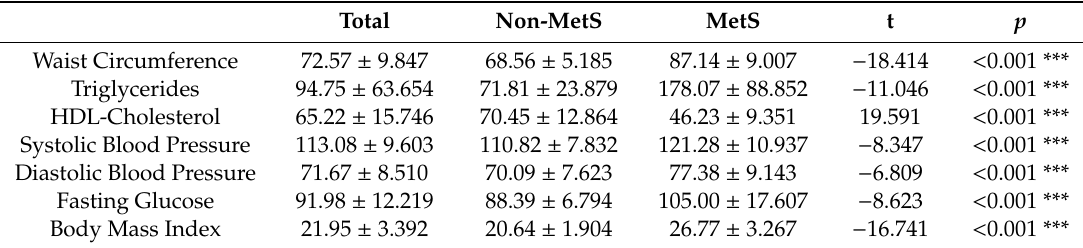
Table 2. Di ff erences in Risk Factors for Metabolic Syndrome and Body Mass Index.